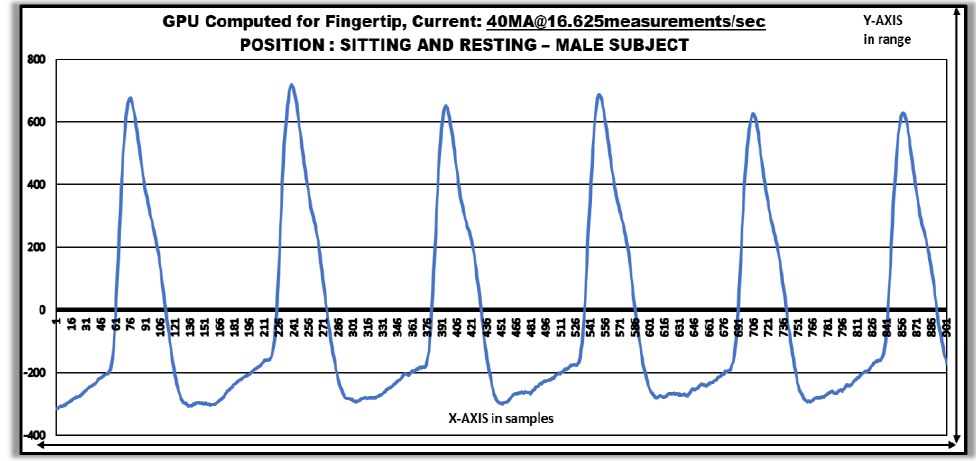
Figure 9. GPU-Computed Data Using Fingertip: Observation Set A.